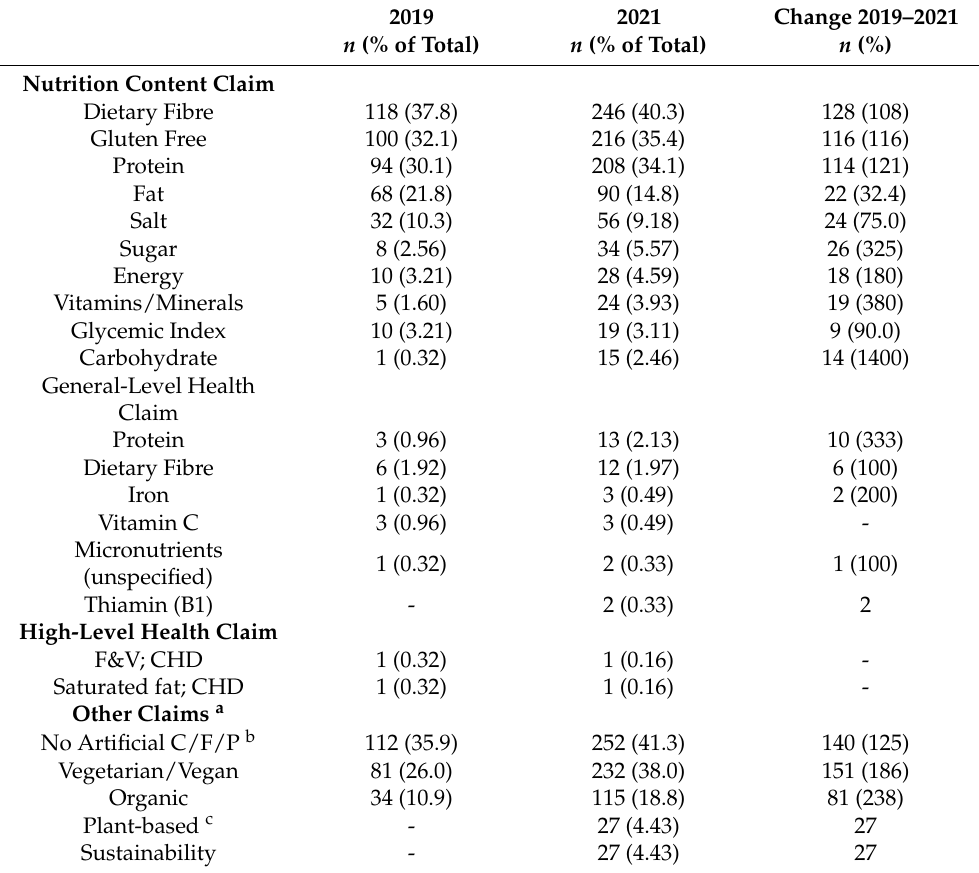
Table 5. Frequency of legume products displaying nutrition content and health claims in 2019 and